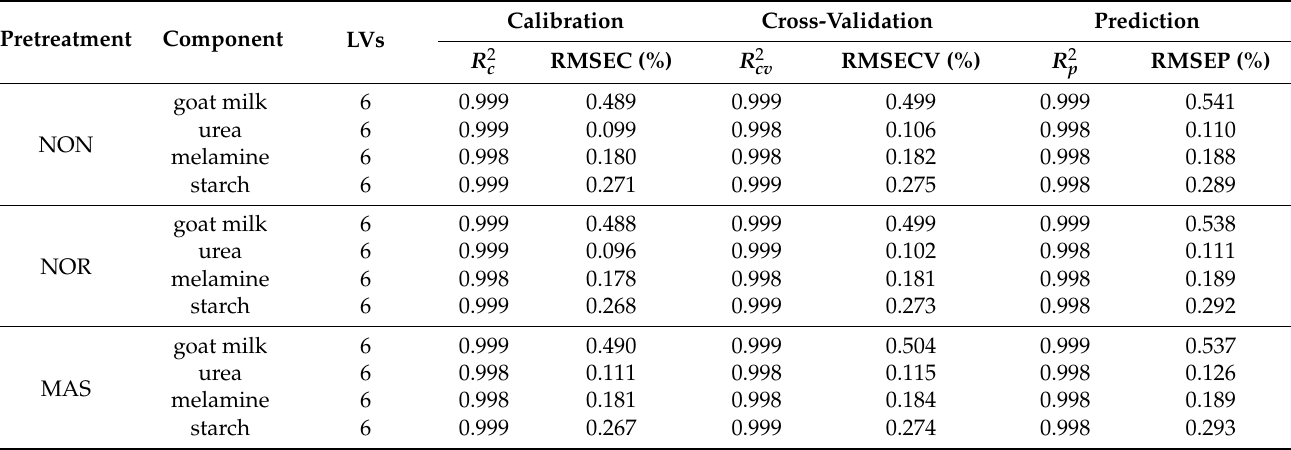
Table 5. Performance of the PLS2 models for multiple-adulterants samples using different pretreat- ment methods based on the full spectral